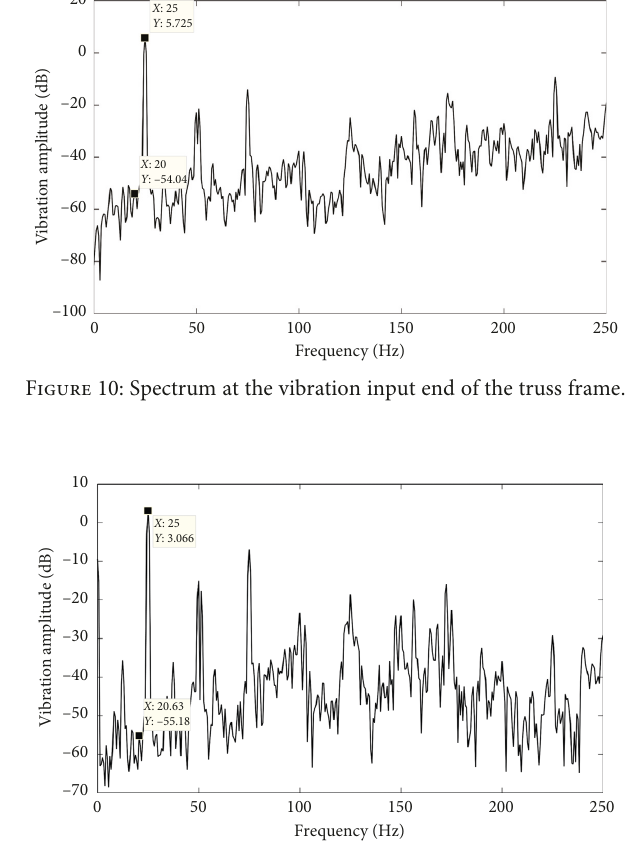
Figure 11: Spectrum at the vibration output end of the truss frame. Table 3: Acceleration-vibration level difference of raft frame at specific